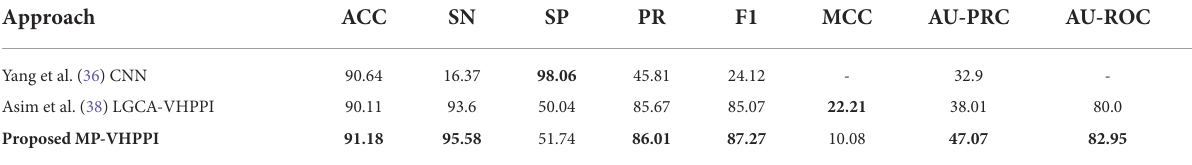
TABLE 5 Performance comparison of the proposed predictor with the existing Yang et al. (36) predictor over the Coronavirus dataset. Approach